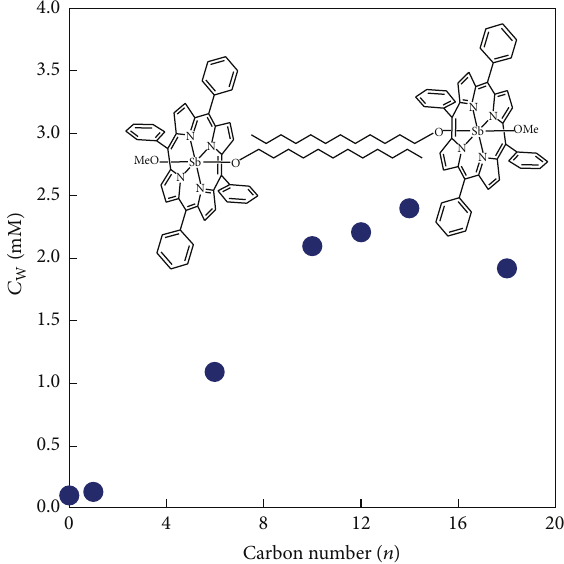
Figure 1: Dependence of water solubility ( 𝐶 number ( 𝑛 ) of axial alkyl ligands. Plausible structure of aggregation of 2 in aqueous solution was shown in